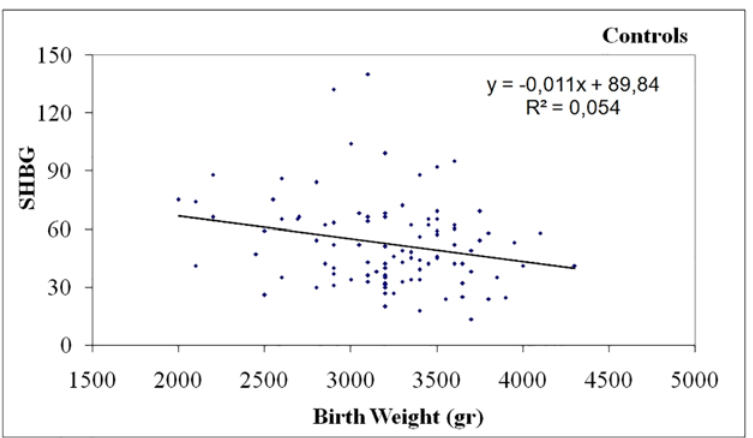
Fig 4. Negative correlation of birth weight with SHBG levels in